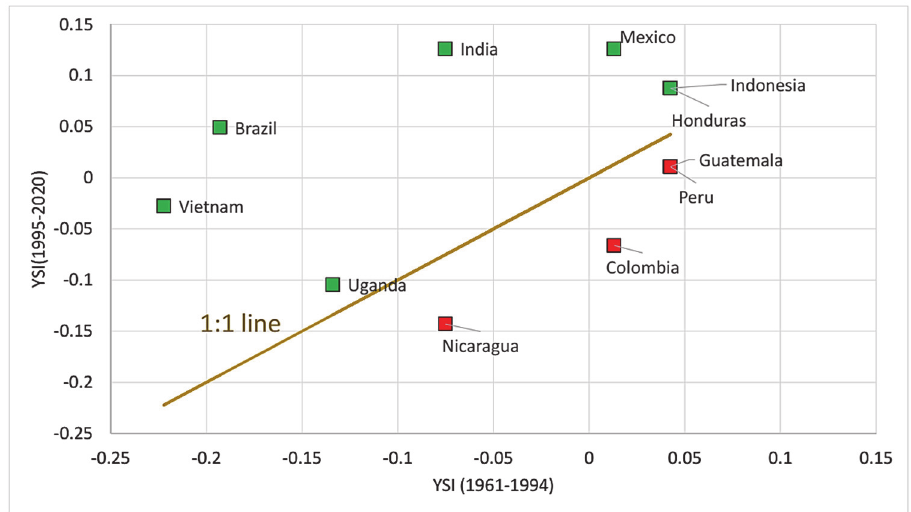
Figure 6. Comparison of Yield Stability Index values in 1961–1994 and 1995–2020. Source: authors’ own construction.